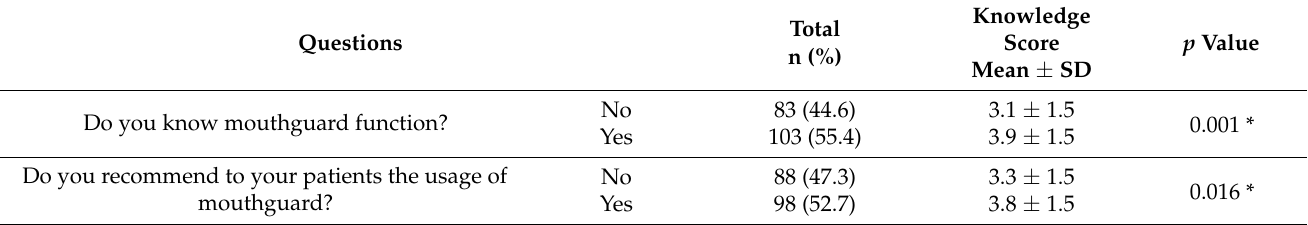
Table 4. Pediatrician’s knowledge regarding dental mouthguard (n =